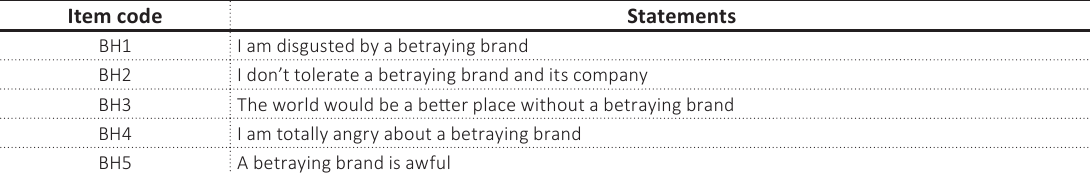
Table A2. Brand hate (BH) Item code